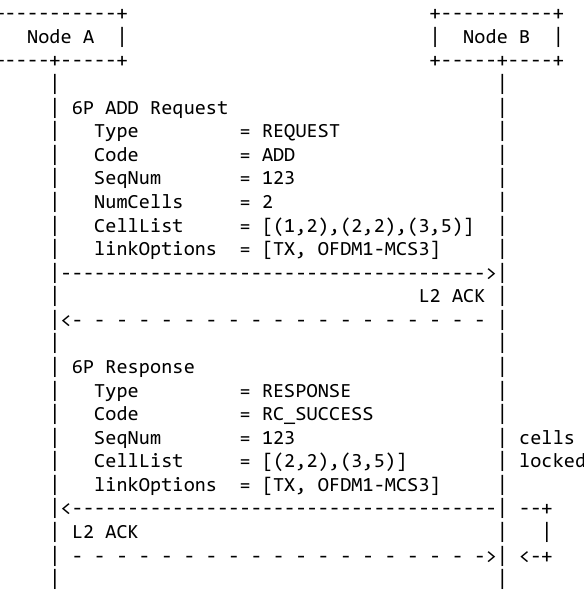
Figure 6. A 6P ADD transaction when using